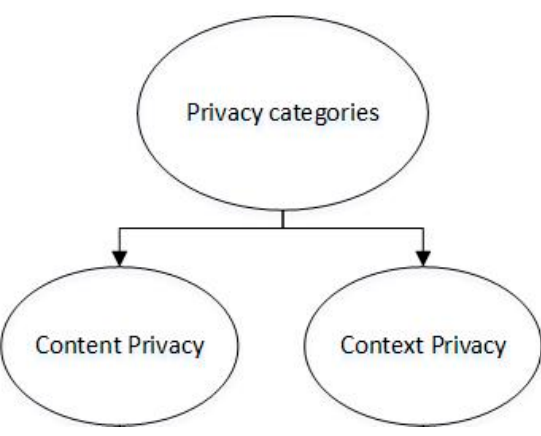
Figure 2. Privacy categories in wireless sensor networks.